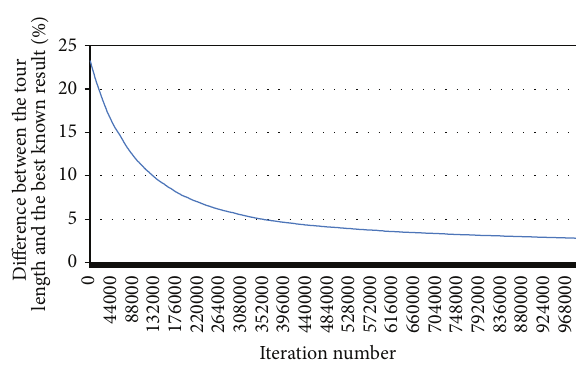
Figure 20: The percentage difference between the length of the current best tour and the best known result for the Mona Lisa TSP Challenge in consecutive